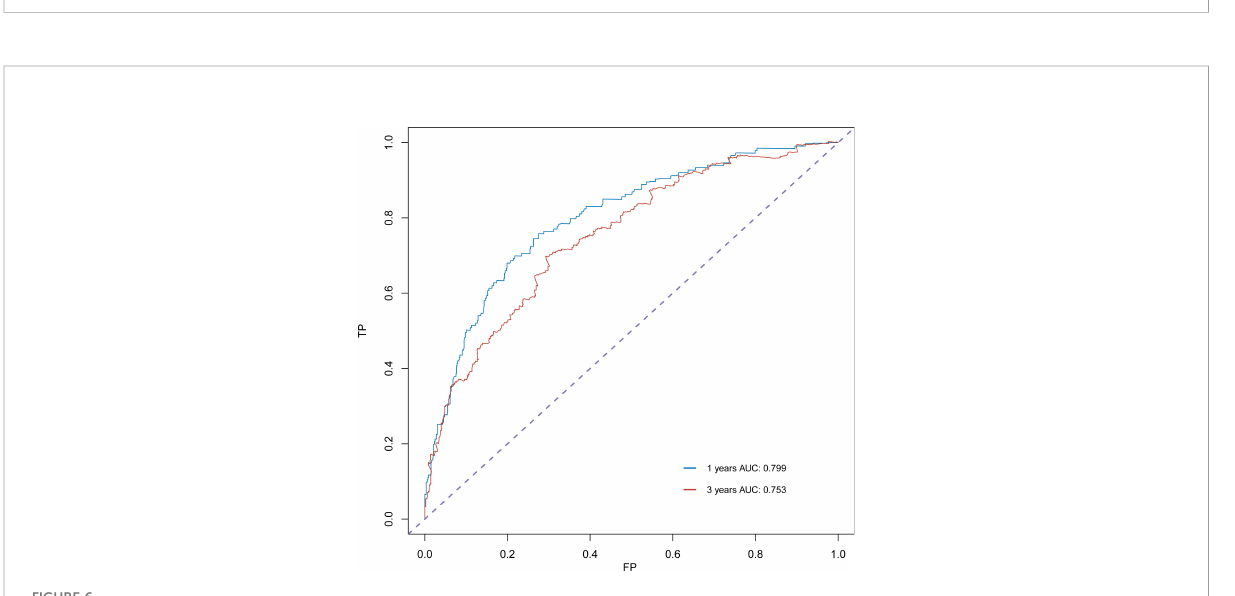
FIGURE 5 ROC curve analysis to predict 1-, 3- and 5-year OS and CSS rates in merkel cell carcinoma Patients. (A) ROC curves for OS in the training cohort. (B) ROC curves for OS in the validation cohort. (C) ROC curves for CSS in the training cohort. (D) ROC curves for CSS in the validation cohort. AUC, area under the curve; ROC, receiver operating characteristic; TP, true positive rates; FP, false positive rate.